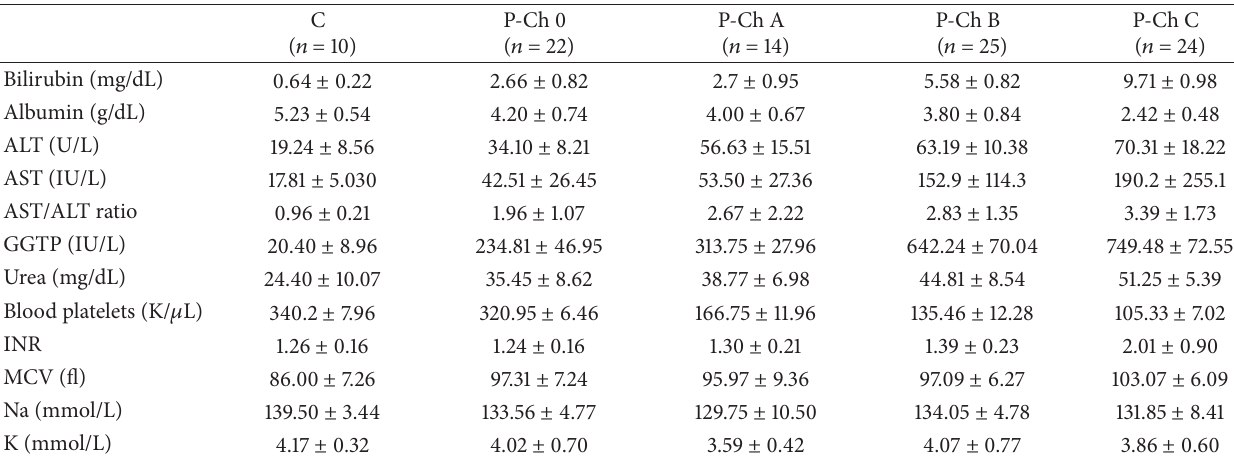
Table 2: Biochemical data of the study